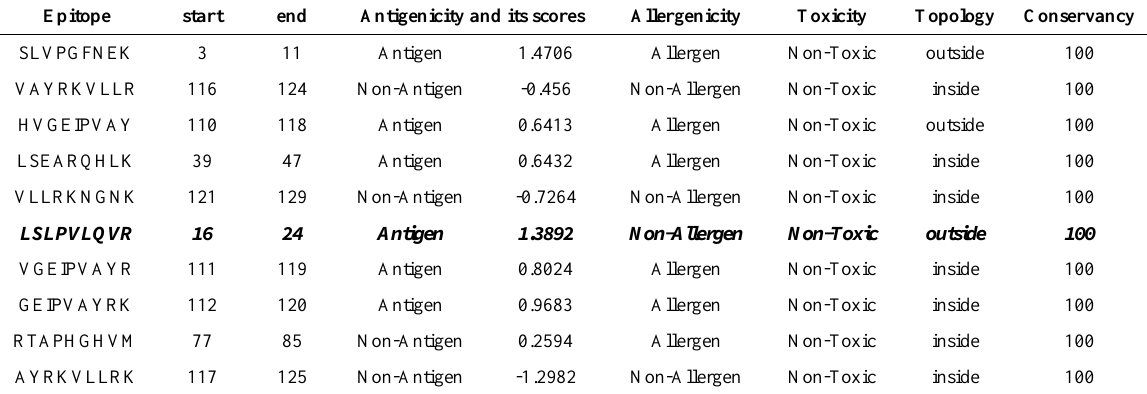
Table 6. List of MHC Class-I epitopes for selected leader protein ORF1ab MT326175 along with their antigenicity, allergenicity, toxicity, topology and conservancy. The epitope in bold italics is selected for further 3D Structure generation.